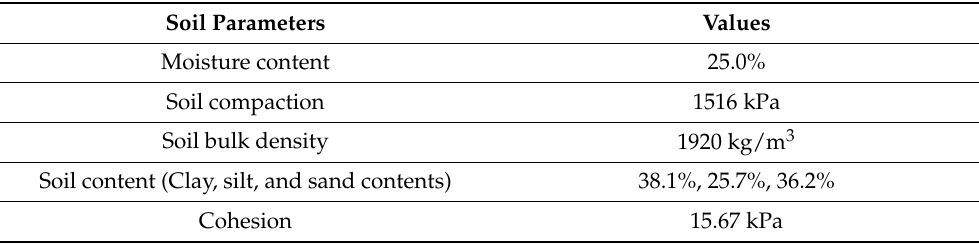
Table 2. Parameters of the soil sample.